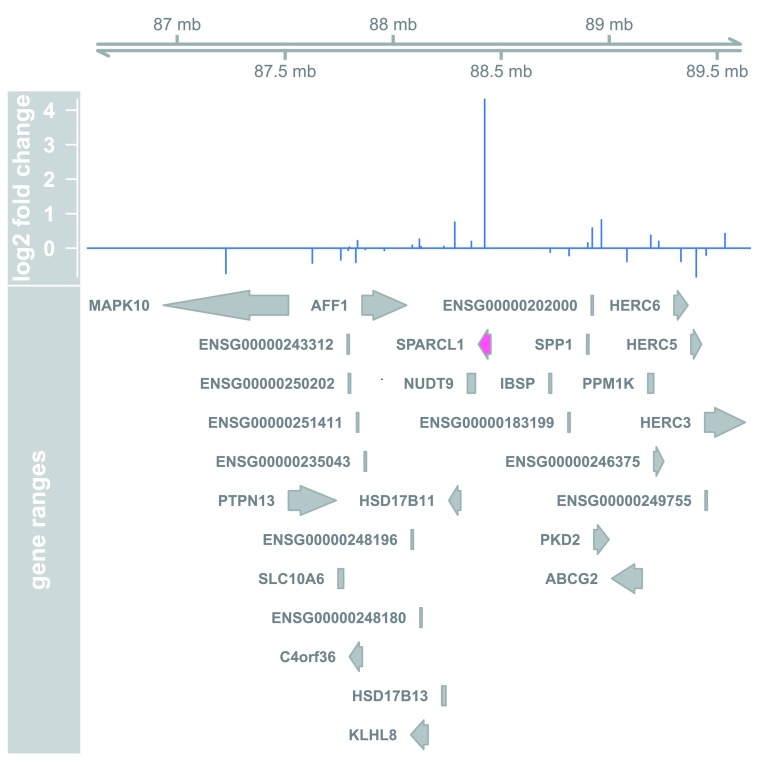
Plotting log2 fold changes in a genomic region surrounding the gene with smallest adjusted
p value.Genes highlighted in pink have adjusted
p value less than 0.1.